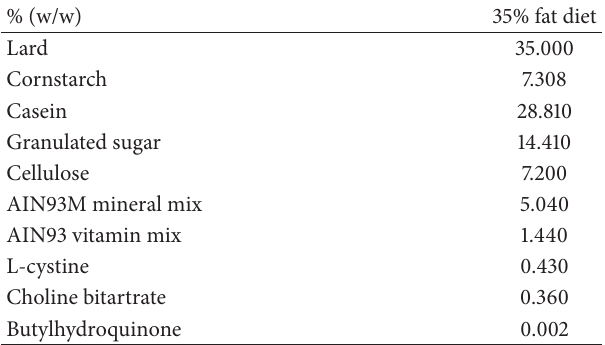
Table 1: Composition of the experimental